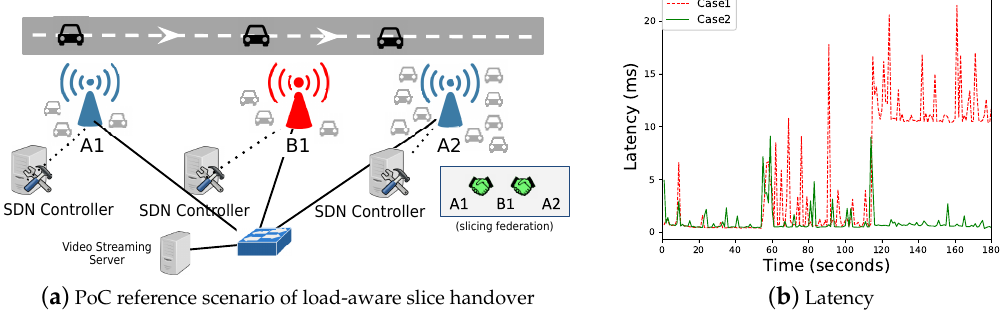
Figure 7. Latency perceived by the targeted vehicle with and without slicing federation ( b ) in the reference scenario shown in ( a